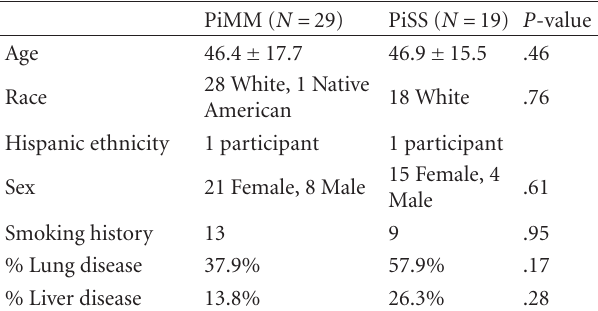
for bronchodilators ( P = .44), corticosteroids ( P = .96), or psychiatric medications ( P = .95) from the control popula-